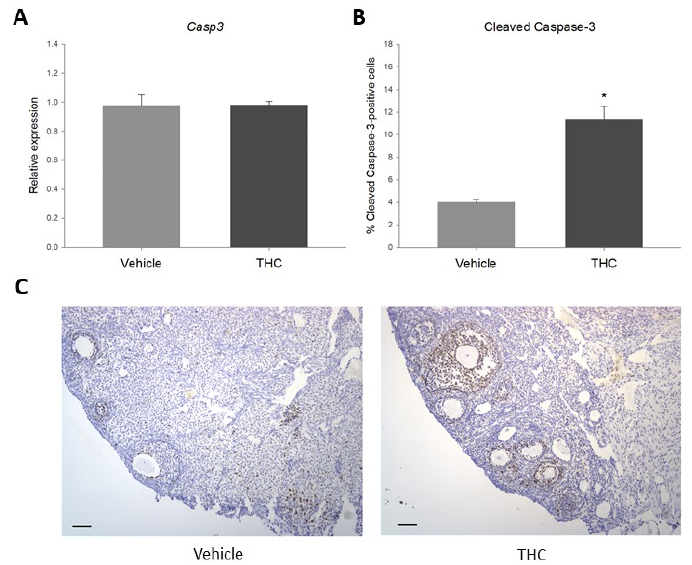
Figure 4. ( A ). Relative expression of Casp3 in prenatally THC-exposed adult rat ovaries. ( B ). Percentage of cleaved caspase-3-positive ovarian follicular cells in prenatally THC-exposed adult rat ovaries. ( C ). Cleaved caspase-3 protein levels in prenatally THC-exposed adult rat ovaries (mean + SEM; N = 5, * p < 0.05). 2.5. Acute Exposure to THC Decreases Expression of Igf1r in the Ovary